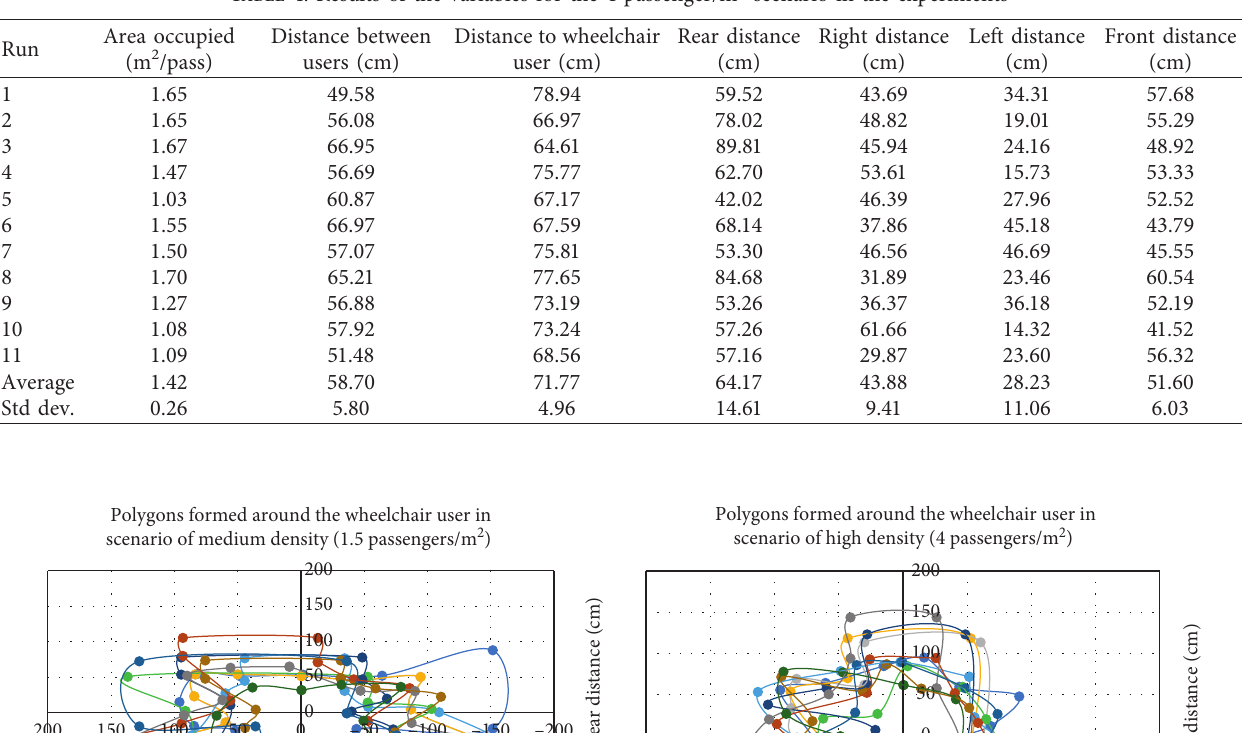
Table 4: Results of the variables for the 4 passenger/m 2 scenario in the experiments